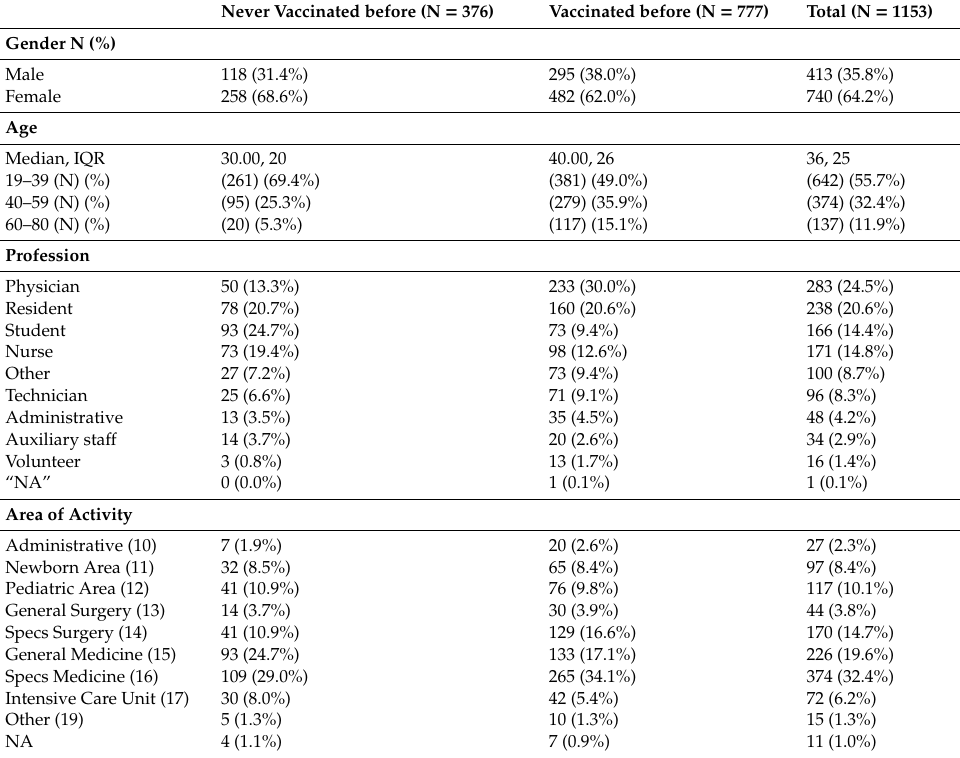
Table 4. Never vaccinated before versus vaccinated before (year